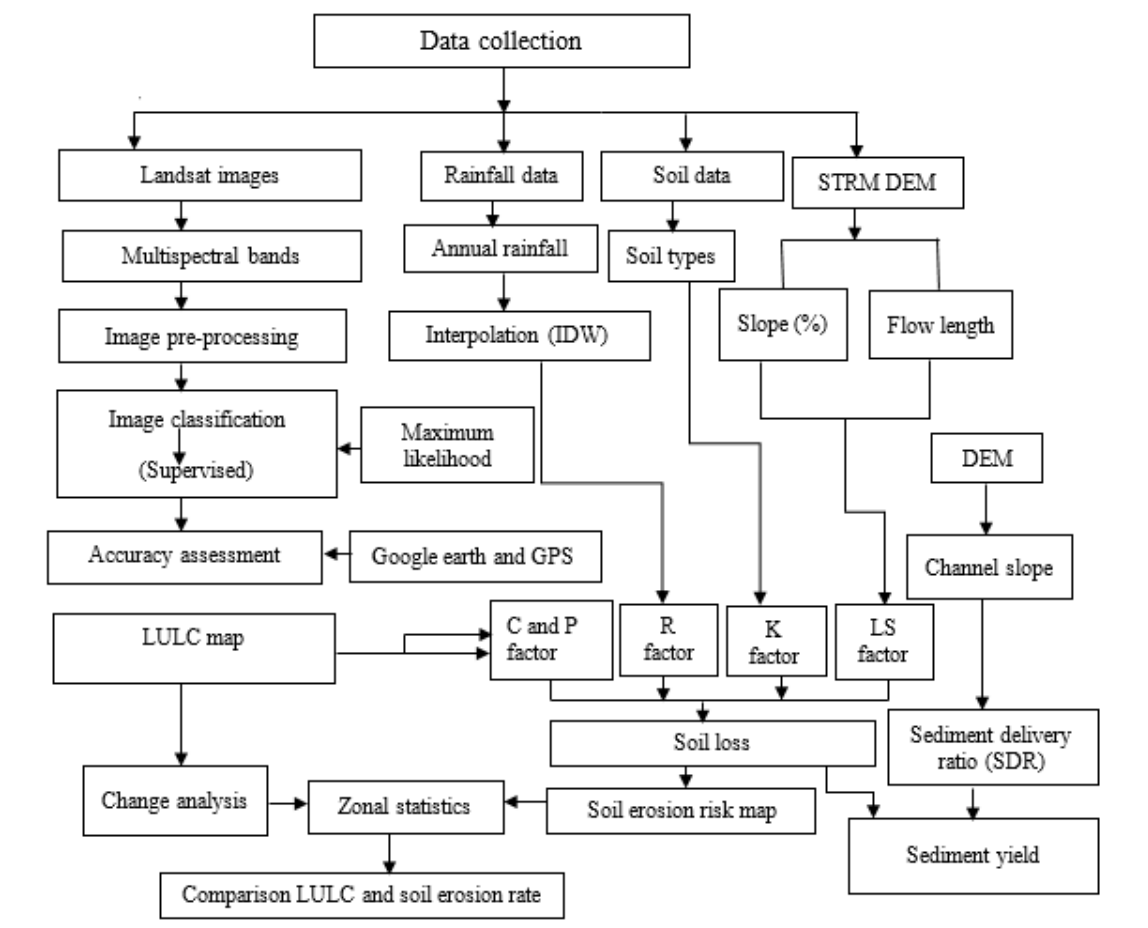
Figure 3. Methodological framework of the study.